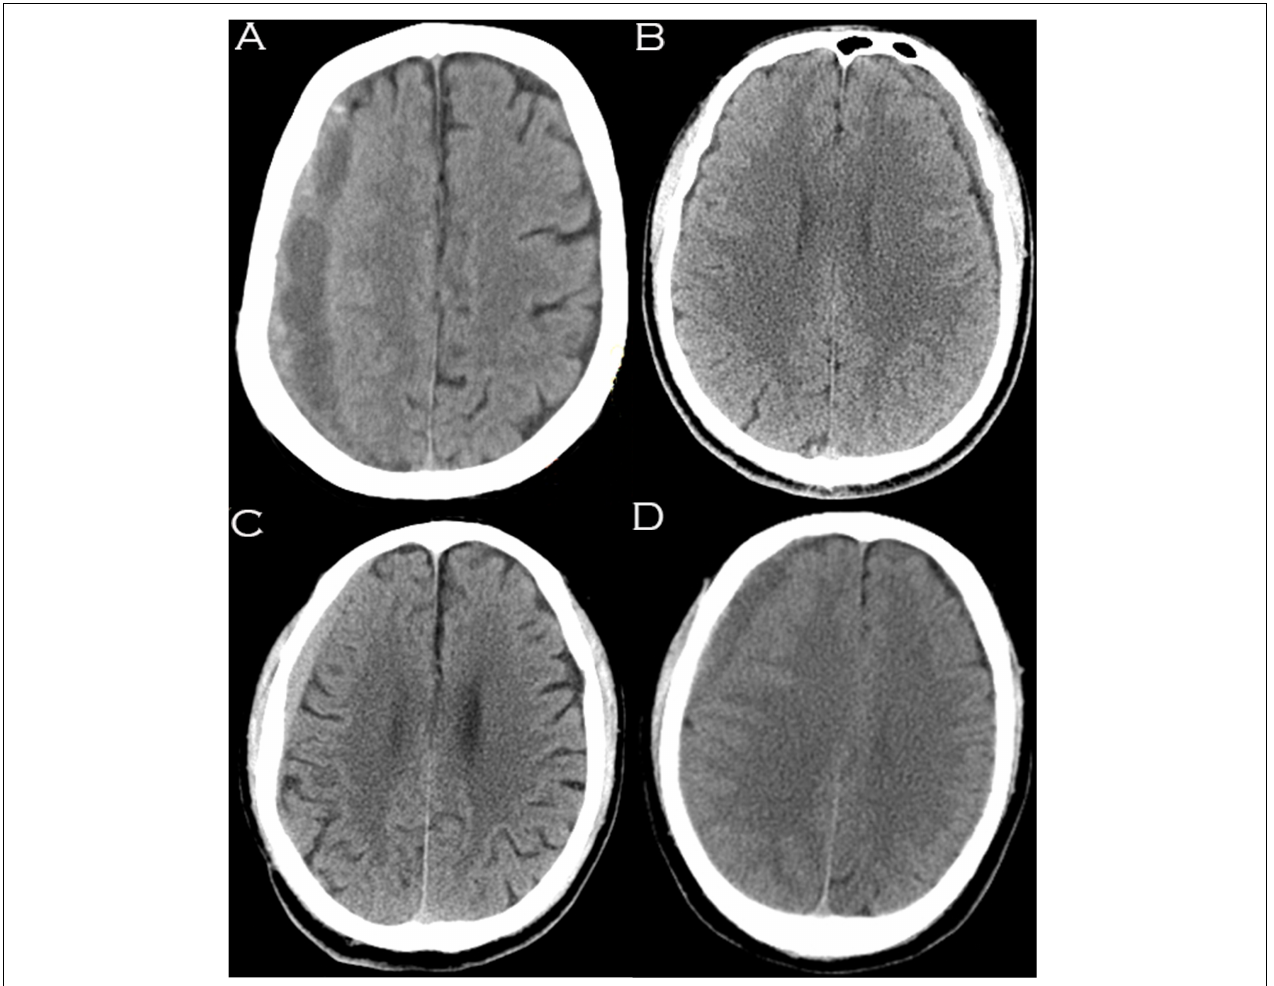
FIGURE 1 | Hematomas of different densities as visualized on computed tomography images. (A) Mixed density hematoma; (B) Isodensity hematoma; (C) Hyperdensity hematoma; (D) Low-density